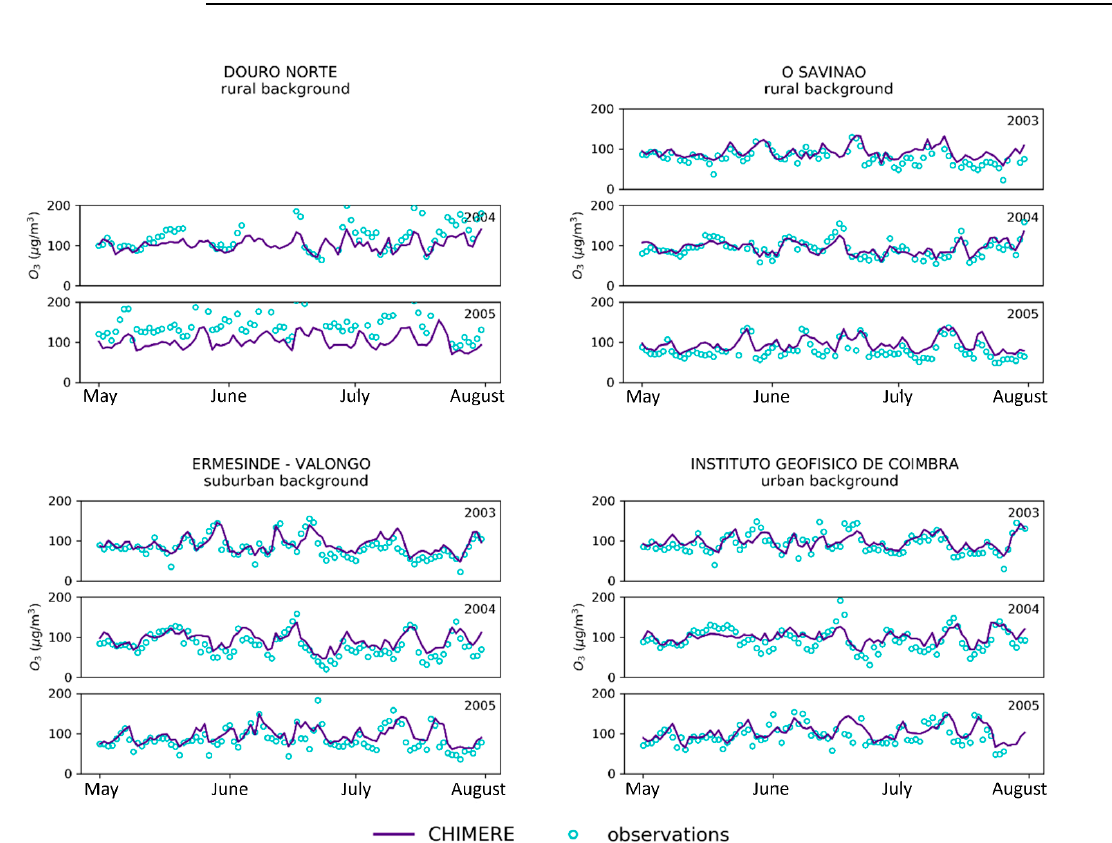
Figure 5. Observed and modelled maximum daily eight-hour mean ozone concentration for different types of monitoring stations.